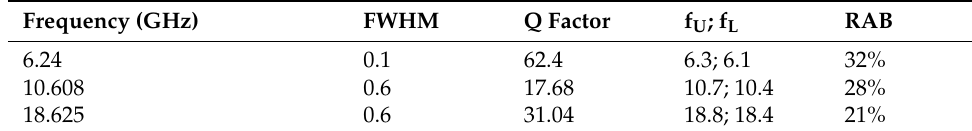
Table 2. The quality factor (Q), FWHM, and RAB results for TM mode.